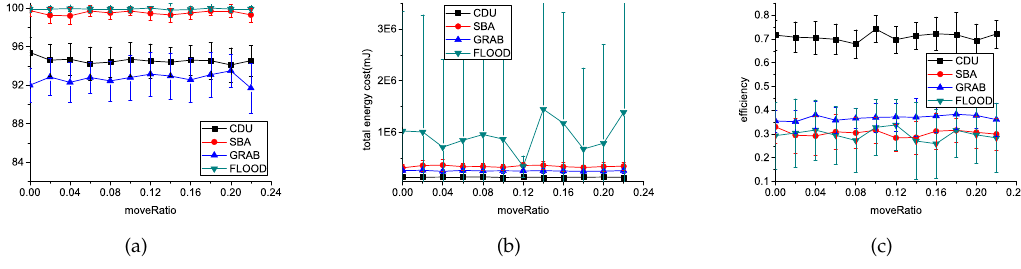
Figure 6. Experimental results with different move ratio using different algorithms. ( a ) introduces the comparisons of the number of fused information; ( b ) introduces the comparisons of the energy cost on communication; ( c ) introduces the comparisons of the fusion